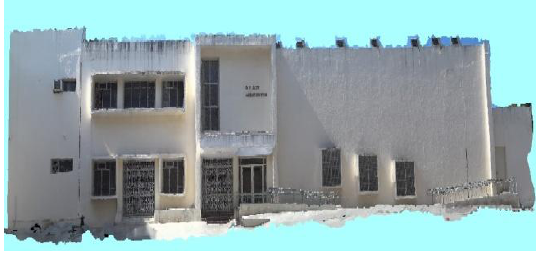
Figure 12: Textured 3D model of O.P.Jain auditorium